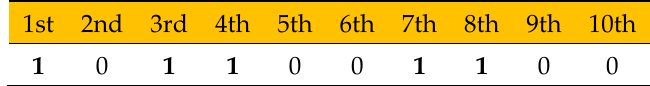
Figure 4. Sample solution with 10 dimensions.